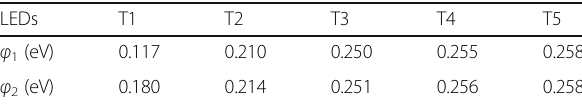
Table 3 Conduction band barrier heights of each NPN-AlGaN junction for LEDs T i ( i = 1, 2, 3, 4, and